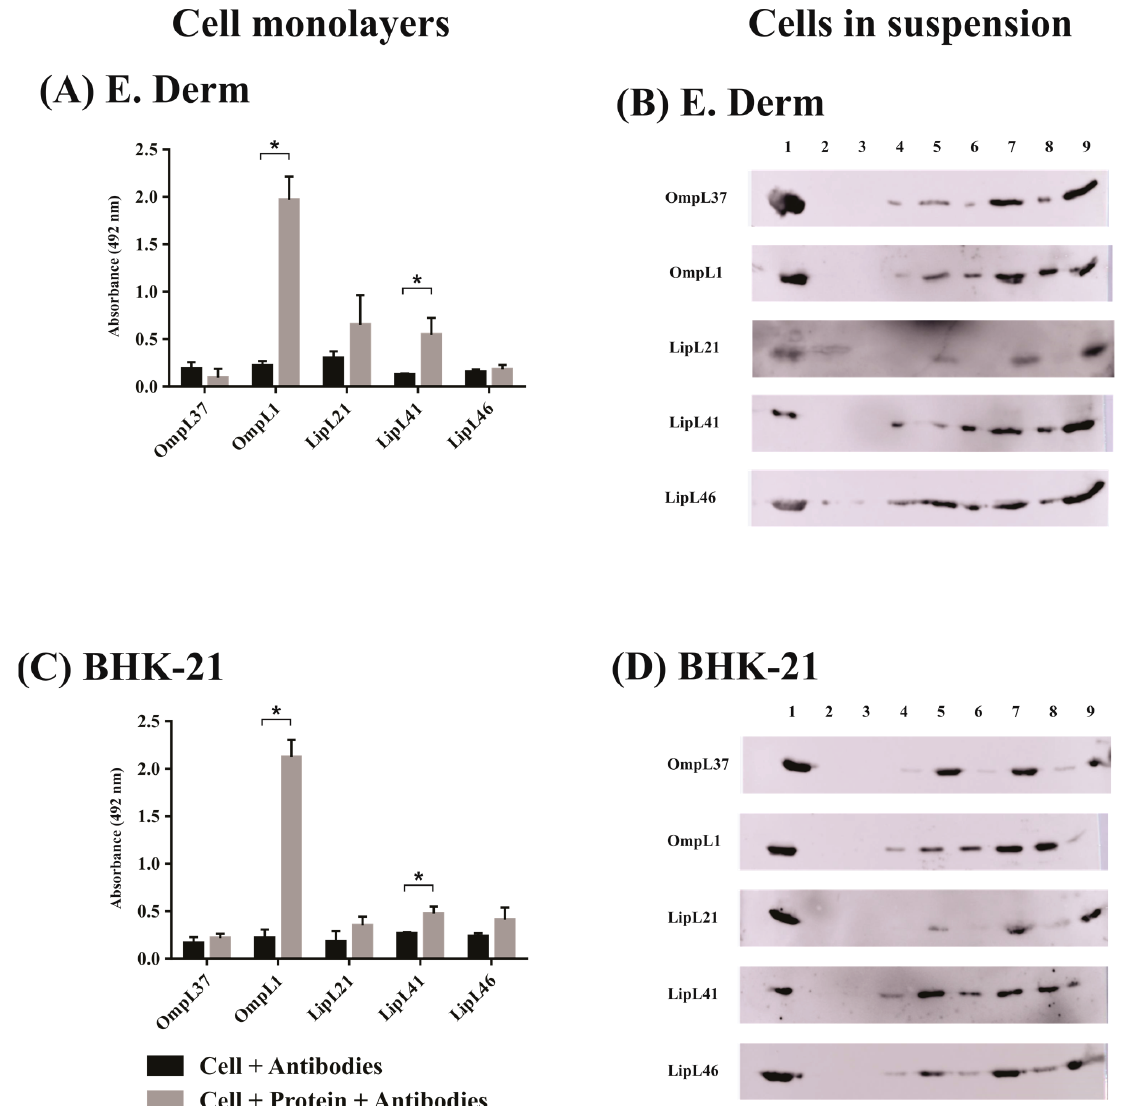
Figure 4. Evaluation of adhesion potential of the major outer membrane proteins from L. interrogans with fibroblasts. Binding of five recombinant membrane proteins, OmpL37, OmpL1, LipL21, LipL41, and LipL46, of L. interrogans to mammalian cells was assessed with cell monolayers (immobilized assay) and detached cells (suspension assay). ( A , C ) : Cell monolayers ( left side ). Ninety-six-well plates were seeded with 10 5 cells/well, and cell confluence was achieved at 37 °C under 5% CO 2 for 24 h. One microgram of each recombinant protein was resuspended in cell media, and 1 µM aprotinin was added for 2 h. Wells without the addition of the proteins were used as negative control. Samples were incubated with anti-recombinant proteins (1:1000) for 1 h. Reaction was detected with anti-mouse IgG-peroxidase (1:5000). The binding of the proteins was compared to the negative controls by the two tailed t -test ( p < 0.05) showed by *. ( A ): E. Derm and C: BHK-21. ( B , D ) : Cells in suspension ( right side ). After cell trypsinization, 2 × 10 5 cells were resuspended in cell media with different protein concentrations in the presence of 1 µM aprotinin for 2 h. The samples were centrifuged at 130 × g for 10 min, and the interaction was assessed by Western blot. ( B ): E. Derm and ( D ): BHK-21. Lanes were described as 1: recombinant protein as positive control; 2–3: pellet and supernatant of negative control without addition of recombinant proteins, respectively; 4–5: pellet and supernatant with addition of 2.5 µ g of protein, respectively; 6–7: pellet and supernatant with addition of 5 µ g of protein, respectively; and 8–9: pellet and supernatant with addition of 10 µ g of protein,